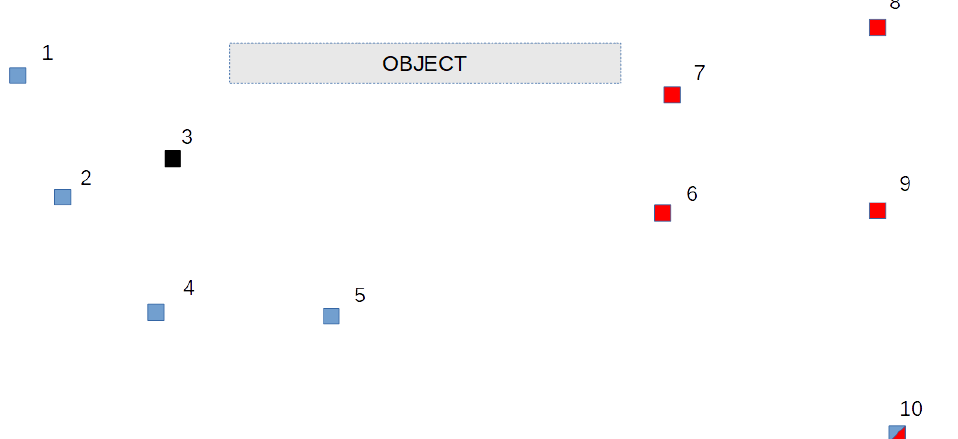
Figure 5. Test network 1 points placement.